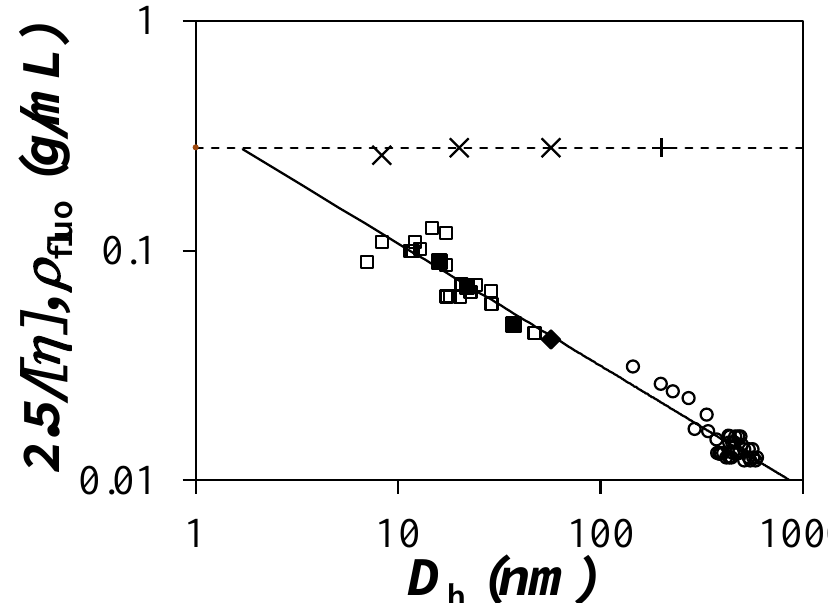
Figure 2. Plot of 2.5/[ η ] obtained by viscometry and ρ luo obtained by pyrene excimer fluorescence (PEF) as a function of D h . Data for 2.5/[ η ]: ( ) the NAFs, ( ) NAF57, ( ) the degraded NAF57 samples, and ( ) a series of samples derived from amylopectin in dimethyl sulfoxide (DMSO). Data for ρ fluo : (×) NAFs and (+) amylopectin [12]. [ η ] = 6.9 × D h0.53.